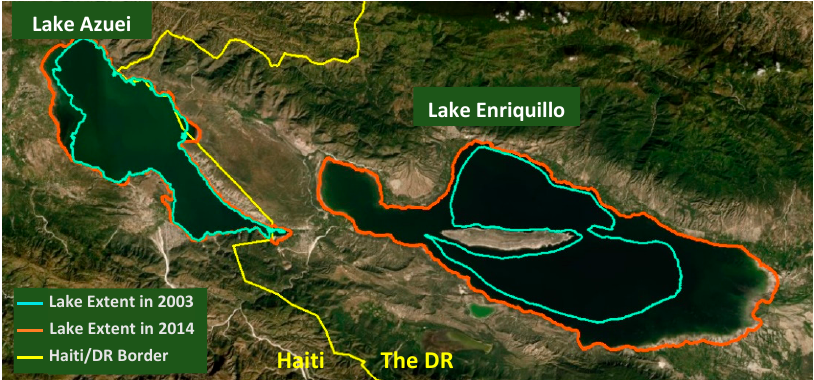
Figure 1. Study Area: Lake Azuei and Lake Enriquillo extent in 2003 and 2014.